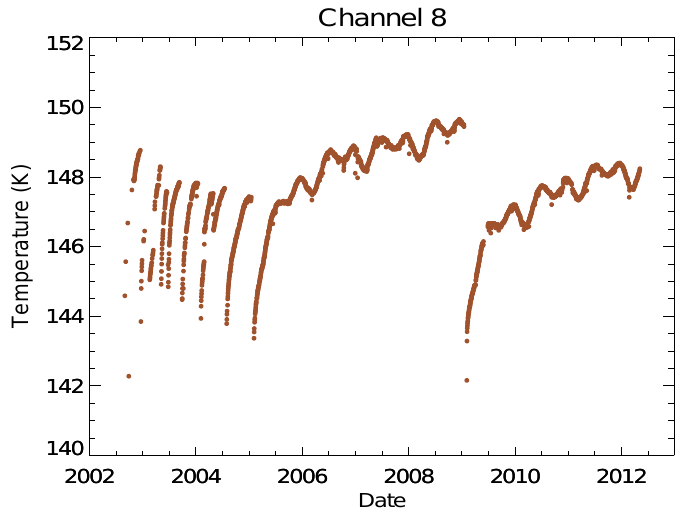
Figure 19. SCIAMACHY temperature variation over time of channel 8. It shows a small period of noisy variations at the beginning of the mission and then increases over time. After the decontamination from 19 December 2008 (orbit 35574) until 3 January 2009 (orbit 35783), the average temperature